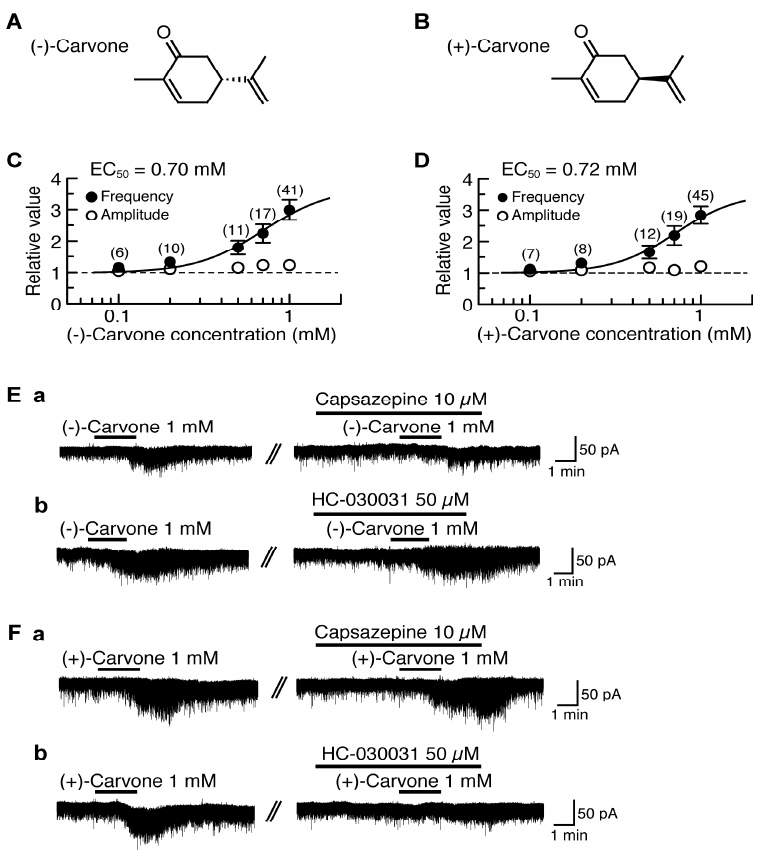
Figure 2. Effects of ( − )-carvone and (+)-carvone on glutamatergic spontaneous excitatory transmission in rat SG neurons. ( A , B ) The chemical structures of ( − )-carvone ( A ) and (+)-carvone ( B ). ( C , D ) The frequency and amplitude of sEPSC under the action of ( − )-carvone ( C ) or (+)-carvone ( D ), relative to those before drug superfusion, which were plotted against the logarithm of drug concentration. This carvone effect was measured for 0.5 min around 3 min after the beginning of its superfusion. The continuous curves in ( C ) and ( D ) were drawn according to the Hill equation (EC 50 and n H in ( C ) and ( D ): 0.70 mM, 2.2 and 0.72 mM, 2.4, respectively). ( Ea,b, Fa,b ) Chart recordings showing sEPSCs in the absence and presence of ( − )-carvone ( E ) or (+)-carvone ( F ) in Krebs solution without (left) and with capsazepine ( Ea, Fa ) or HC-030031 ( Eb, Fb ; right). In each of ( Ea,b, Fa,b ), the right recording was obtained about 20 min after the left one from the same neuron. V H = − 70 mV. This research was originally published in [101].